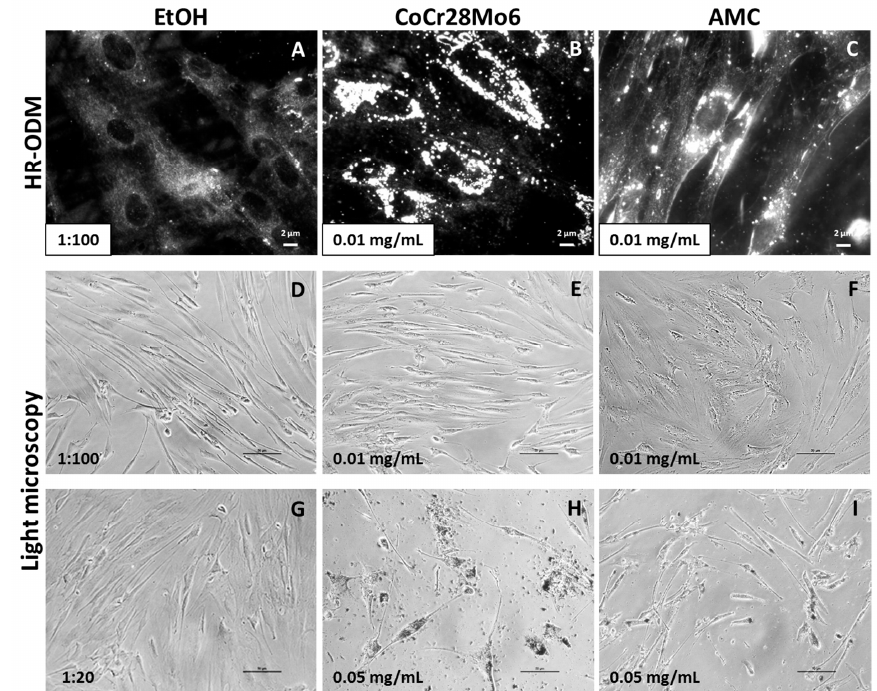
Figure 4. Representative pictures of human primary fibroblasts exposed to CoCr28Mo6 and AMC particles using HR-ODM ( A – C ; scale bar: 2 µm) and light microscopy ( D – I ; scale bar: 50 µm). Since particles were kept in EtOH to avoid agglomeration, control cell cultures were treated with EtOH in the respective concentration ( A , D , G